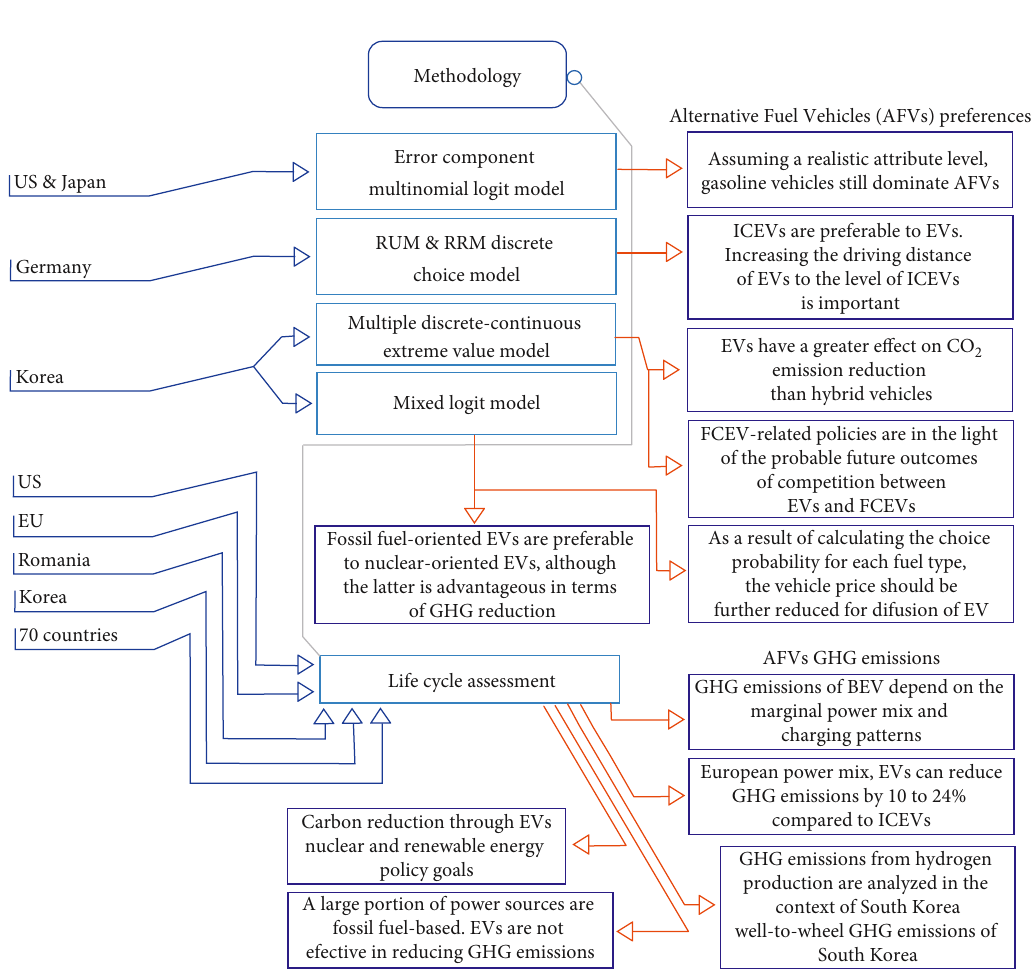
Figure 8: Summary of the relevant